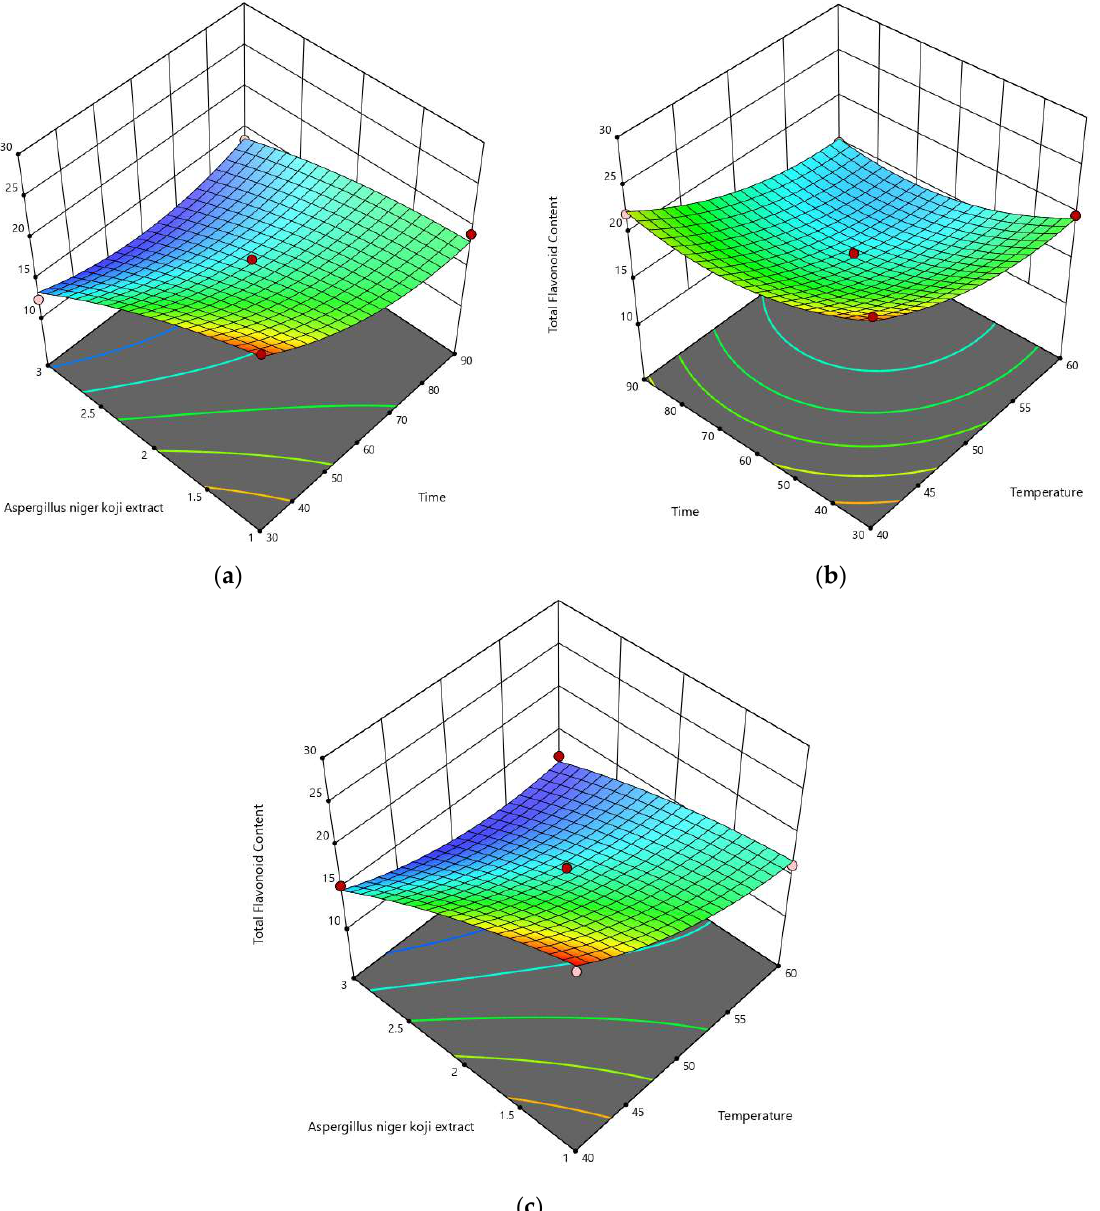
Figure 4. Three-dimensional response surface plots for TFC as affected by processing parameters ( a – c ).